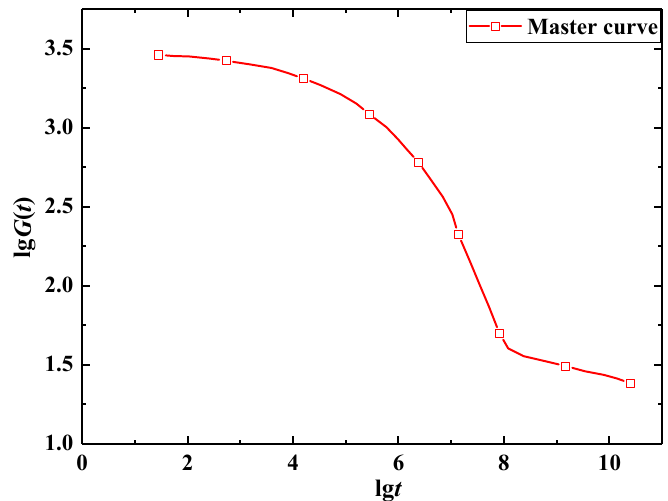
Figure 8. Translational change of the modulus at 30 °C.